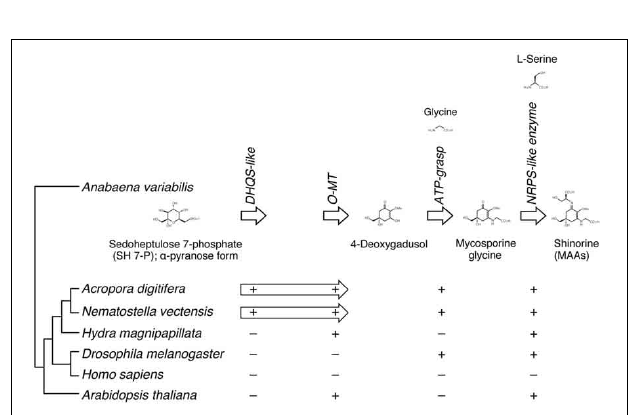
FIGURE 6 | The genes required for the biosynthesis of shinorine are present in anthozoan cnidarians. (Upper) The organization of gene cluster involved in the biosynthetic pathway of the photo-protective molecule shinorine, a mycosporine-like amino acid, in the cyanobacterium Anabaena variabilis. (Lower) The presence of corresponding genes in various organisms is indicated by “ + .” The Acropora and Nematostella genomes contain homologs of each of the four genes, in which DHQS-like and O-MT are fused each other.